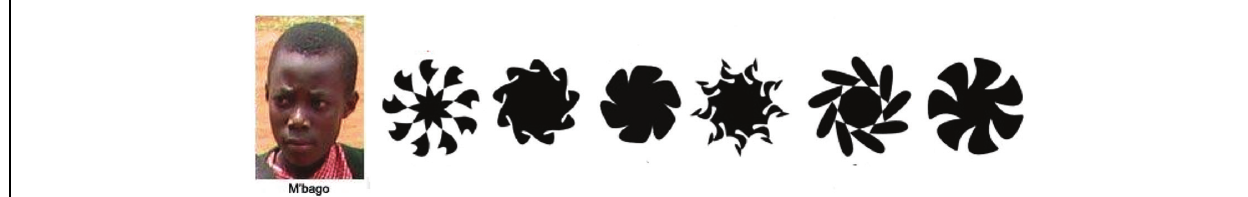
FIGURE 3 | Child and shapes used in the visual distraction experiment in Study